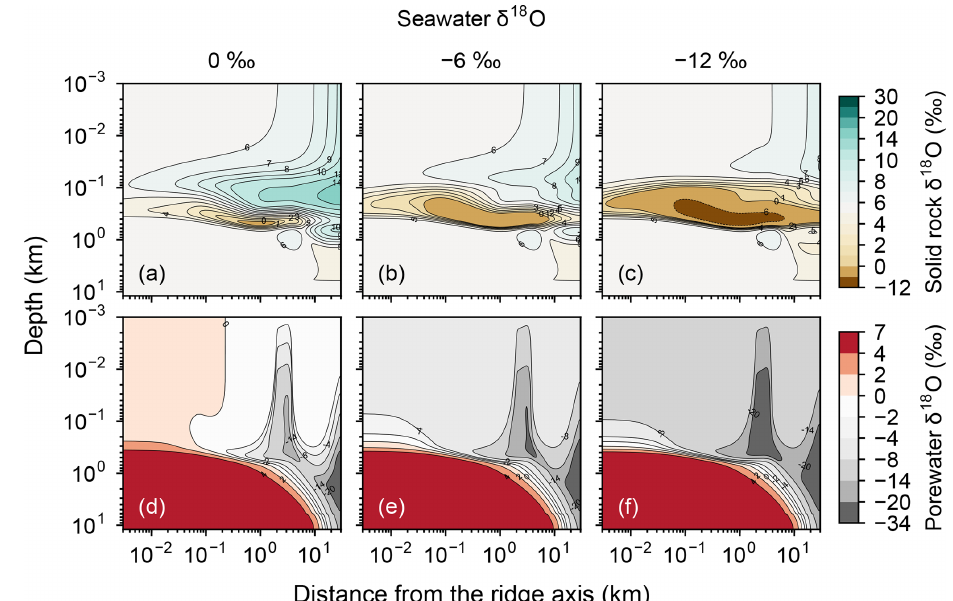
Figure 3. As for Fig. 2, except plotted on logarithmic